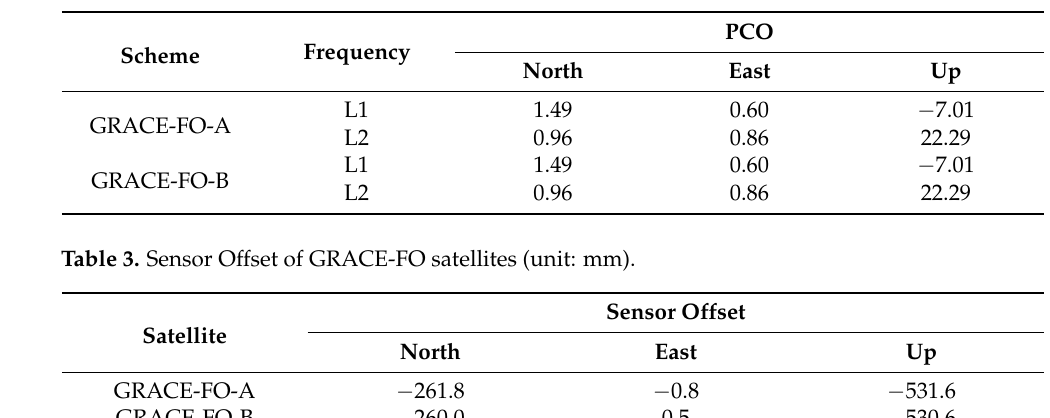
Table 2. PCO of GRACE-FO satellites (unit: mm).